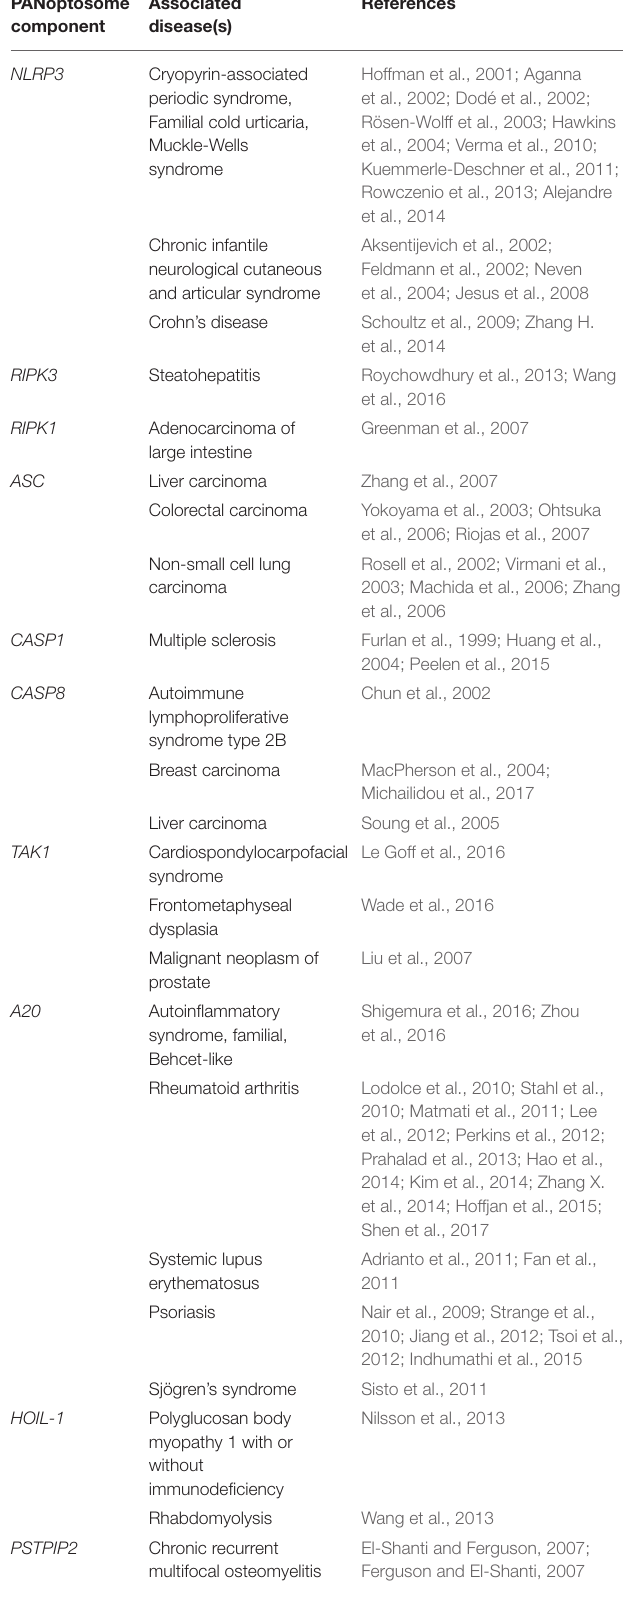
TABLE 1 | A list of PANoptosome components and associated human